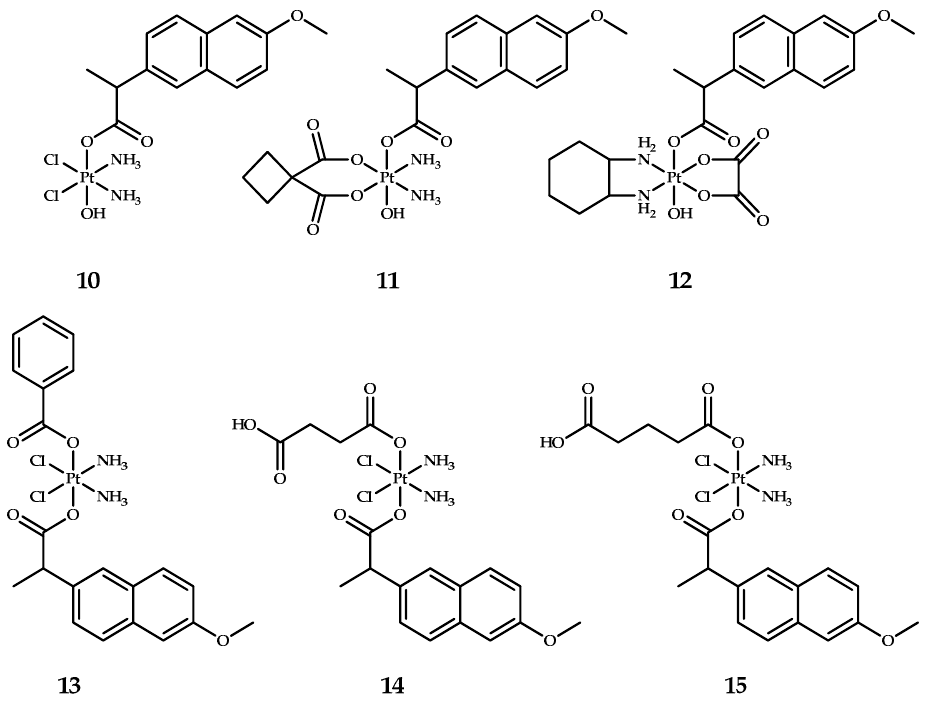
Figure 8. Naproxen-containing mono-carboxylated platinum(IV) prodrugs based on cisplatin 10 , carboplatin 11 and oxaliplatin 12 and di-carboxylated 13–15 .